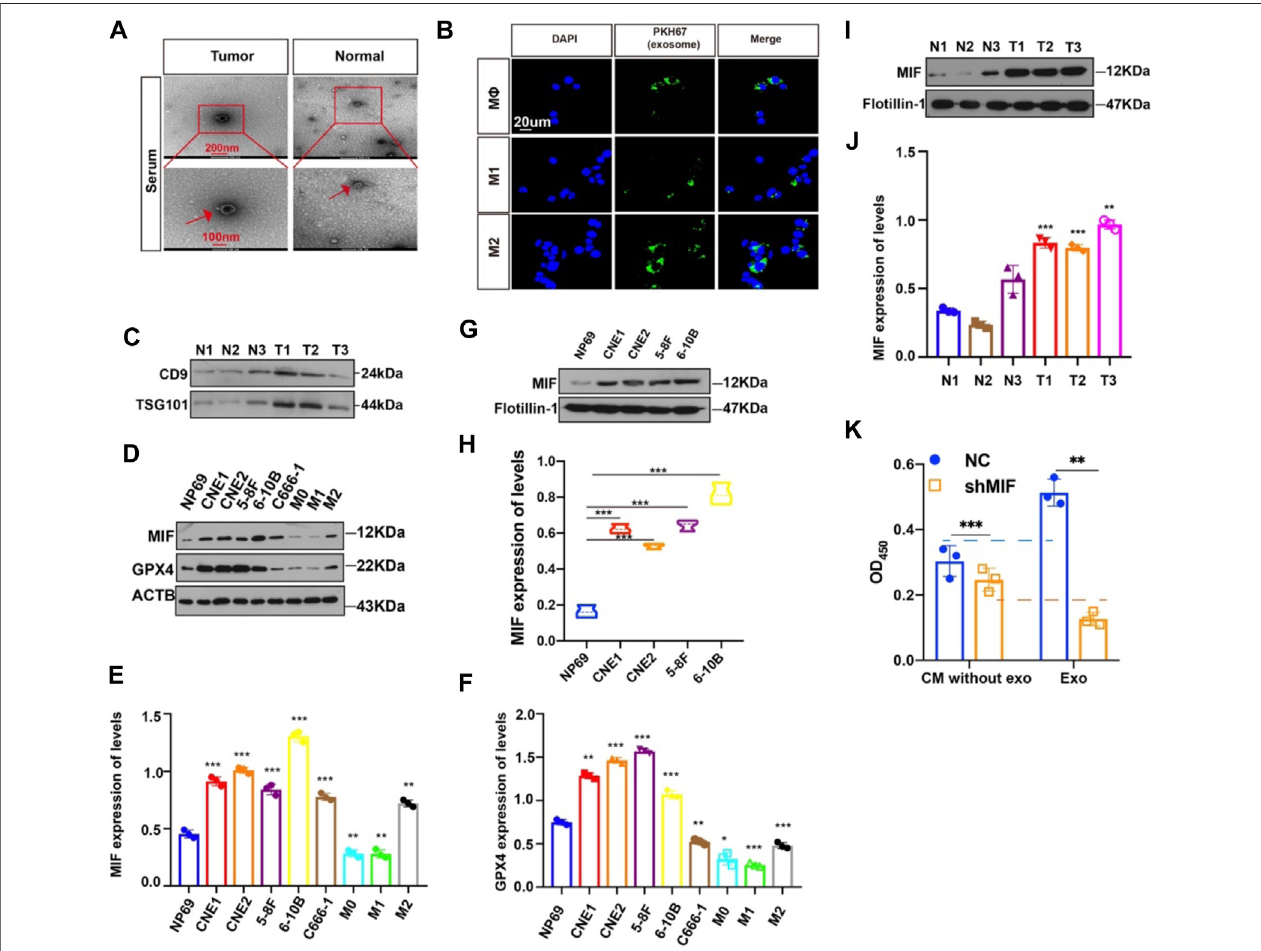
FIGURE 5 | MIF can be transferred from NPC cells to Møs via exosomes. (A) Representative electron microscopy images of NPC-exos and Normal-exos. (B) Uptake of exosomes in macrophages by confocal microscopy. Exosomes are derived from the serum of NPC patients. Blue: DAPI staining; green: PKH67-labeled exosomes. Scale bar:20 um. (C) Validation of serum-derived exosomes markers (D – F) WB analyses of MIF and GPX4 expression in NPC cell lines, NP69 cells and macrophages (* p < 0.05,** p < 0.01, *** p < 0.001,t-test). (G,H) Analysisoftheexpression level ofMIFinexosomesofNPC and normal cells(ttest). (I,J) Analysisof the expression level of MIF in exosomes in serum from three cases of nasopharyngeal carcinoma and normal controls (t test). (K) CM without exo: the supernatant derivedfromtheCNE2controlandtransfectedknockdownMIFlentivirus,andtheexosomeswereremoved.exo:Exosomes.Allgraphsshowthemean ± SEMofatleast three independent